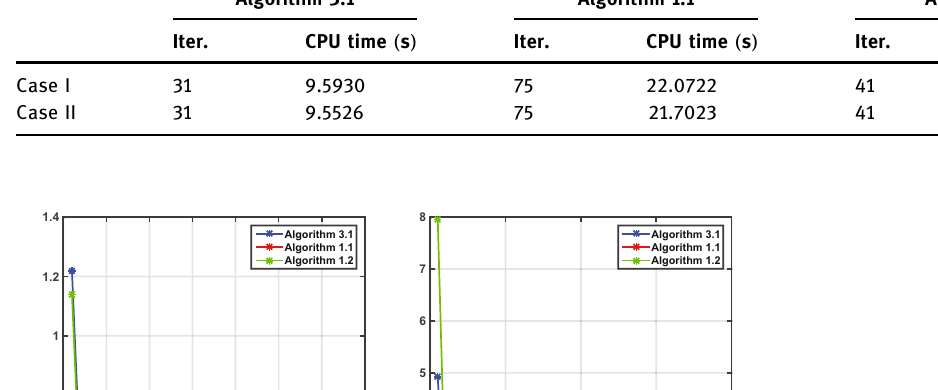
Figure 3: Problem 1, left: Case I; right: Case II.